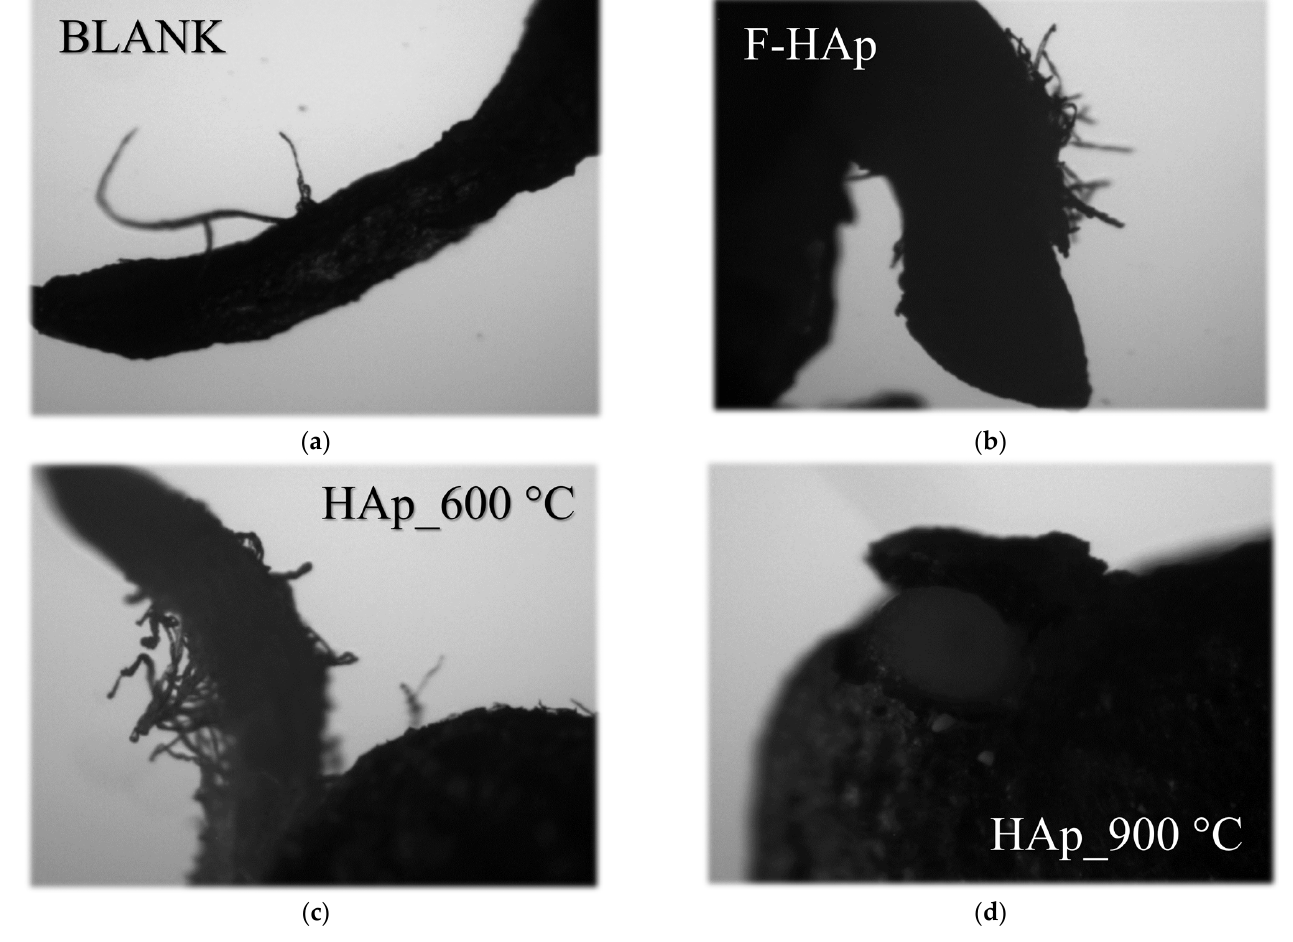
Figure 13. Optical microscopy images of watercress roots after a 4-day germination period of seeds exposed to ( a ) water (blank) and to the Co ‐ adsorbed HAp samples ( b ) F − HAp, ( c ) HAp_600 °C and ( d ) HAp_900 °C. Table 8. Germination viability for watercress seeds exposed to Co ‐ adsorbed HAp obtained from fishery waste.